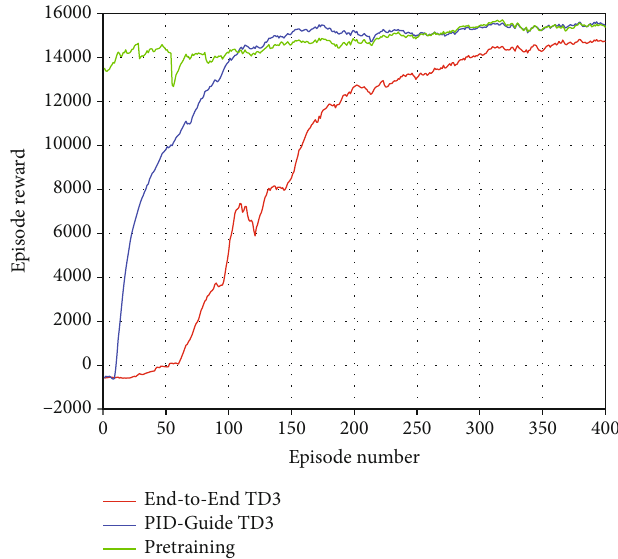
Figure 9: The training process of di ff erent algorithms.